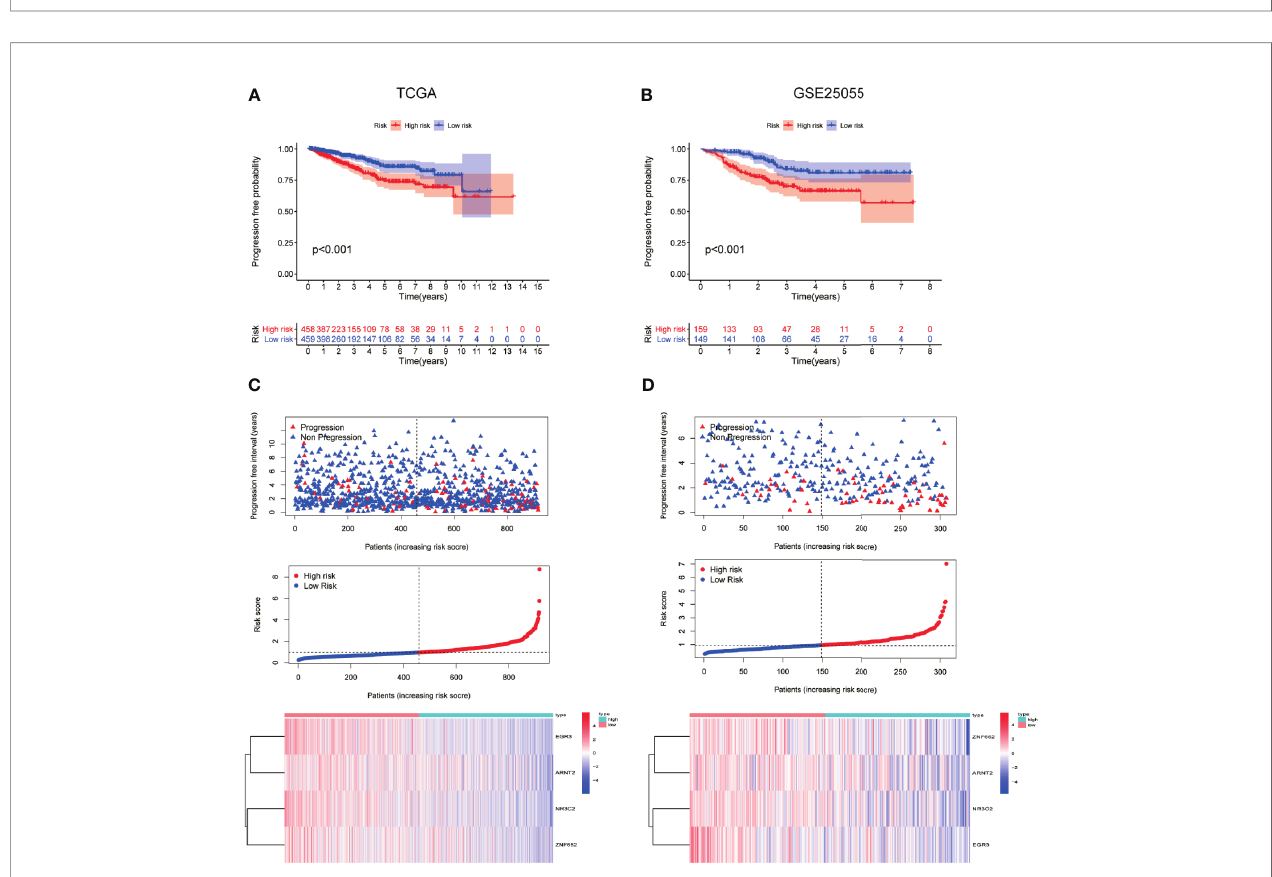
FIGURE 4 | The correlation between TF-related signature for PFI of BC patients. (A, B) Kaplan-Meier PFI curves for the high- and low-risk groups using TCGA and GSE25055 data. (C, D) Distribution of the risk scores, progression free interval status of patients, and heatmap of 4 candidate TFs in the index using TCGA and GSE25055